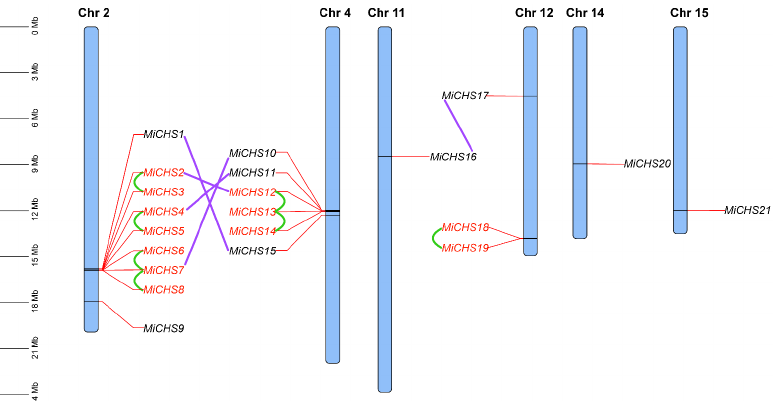
Figure 3. Chromosome distribution analysis of mango CHS gene family. A total of 12 MiCHS genes marked in red font and paired with green arcs are defined as tandem duplication events. Purple lines indicate segmental duplications of the MiCHS genes.